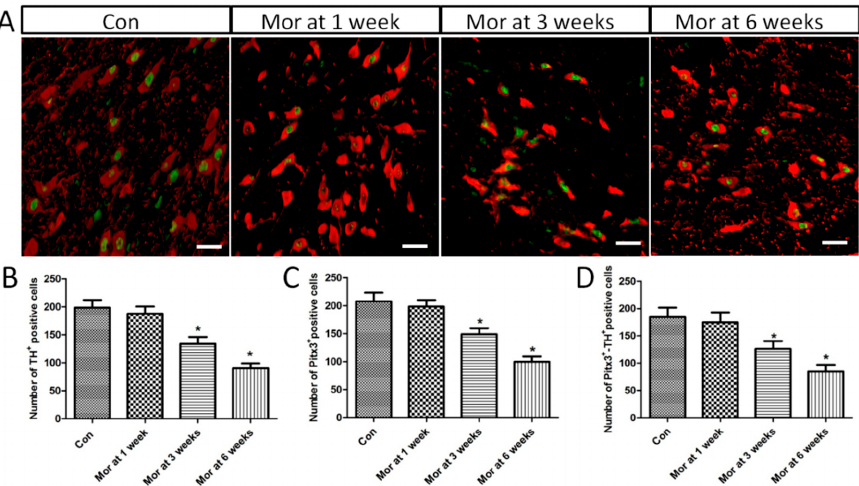
Figure 6. ( A ) Representative images showing the co-localization of Pitx3 and TH positive cell expression in the VTA. Bars = 25 µ m. ( B – D ) Quantitative analysis of TH + , Pitx3 + and Pitx3 + -TH + positive cells. The data are shown as mean ± SEM. * P < 0.05 vs. control group ( n = 8).